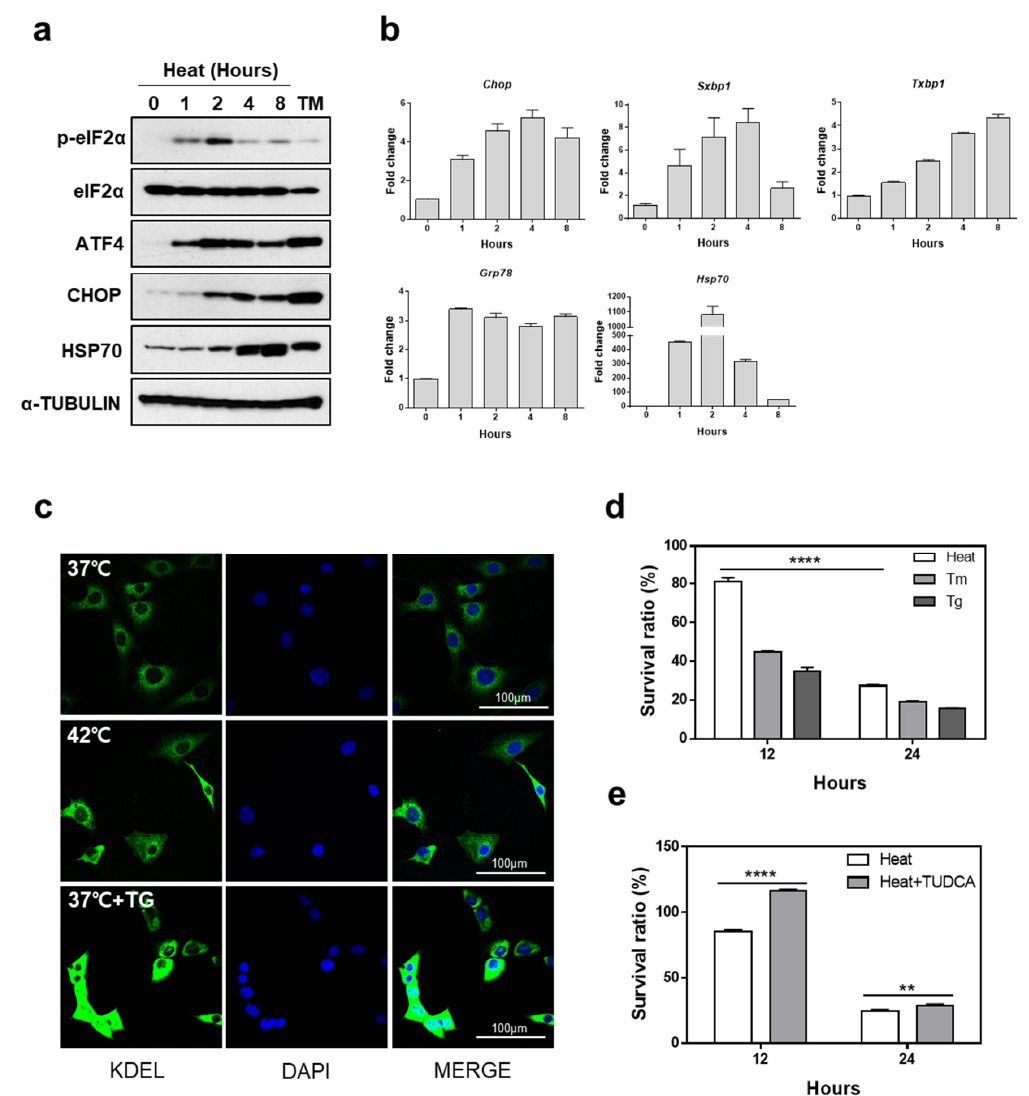
Figure 1. High temperature induces endoplasmic reticulum (ER) stress-mediated cell death. ( a ) Protein expression under condition of hyperthermia was measured. Cell lysates were collected at indicated times following incubation at 42 ◦ C or tunicamycin (Tm) (1 µ g/mL) treatment for western blot analysis. ( b ) Effect of heat stress on the unfolded protein response (UPR) gene expression. Quantitative RT-PCR was performed using total RNA extracted from mouse embryonic fibroblasts (MEFs) which were incubated at 42 ◦ C for indicated time periods. Data are presented as means ± SEM (n = 3 independent experiments). ( c ) KDEL and DAPI immunofluorescence staining. KDEL and DAPI staining were performed using MEFs incubated at 42 ◦ C or treated with thapsigargin (Tg) (300 nM) for 12 h. Representative images are shown. Scale bar represents 100 µ m. ( d ) Cell viability was measured in MEFs treated with Tg (300 nM), Tm (1 µ g/mL), or incubated at 42 ◦ C for the indicated time periods. ( e ) Cell viability was measured in MEFs which were incubated at 42 ◦ C for indicated time periods in the presence or absence of tauroursodeoxycholic acid (TUDCA) (2.4 mM). ** p < 0.01; **** p < 0.0001.